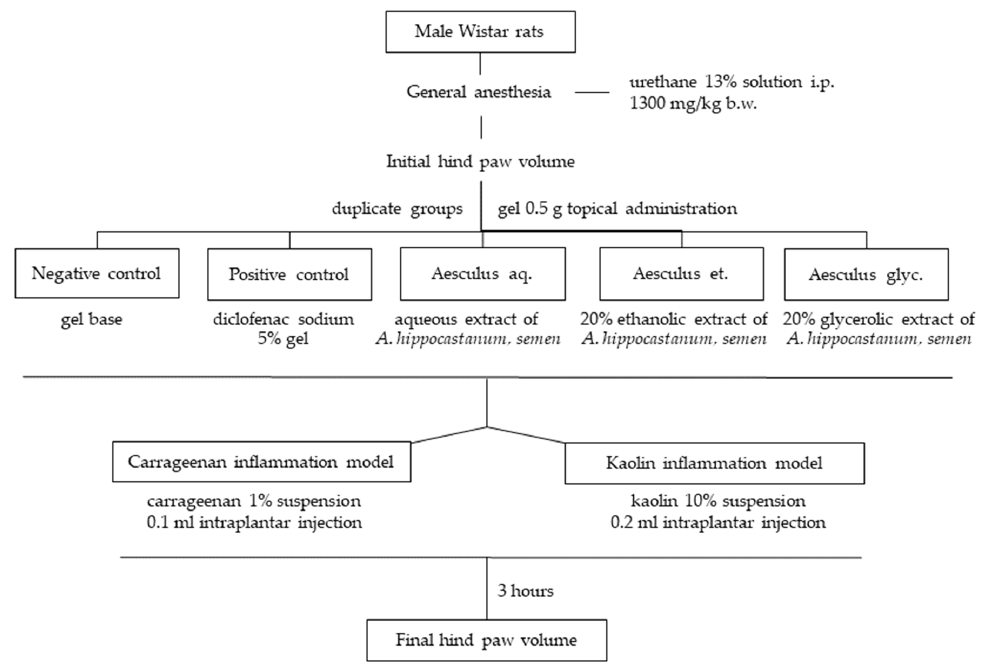
Figure 2. Experimental protocol for anti-inflammatory effect evaluation. Aesculus aq.: Aesculus hippocastanum aqueous extract; Aesculus et.: A. hippocastanum 20% ethanolic extract; Aesculus glyc.: A. hippocastanum 20% glycerolic extract; b.w.: body weight; i.p.: intraperitoneal injection.